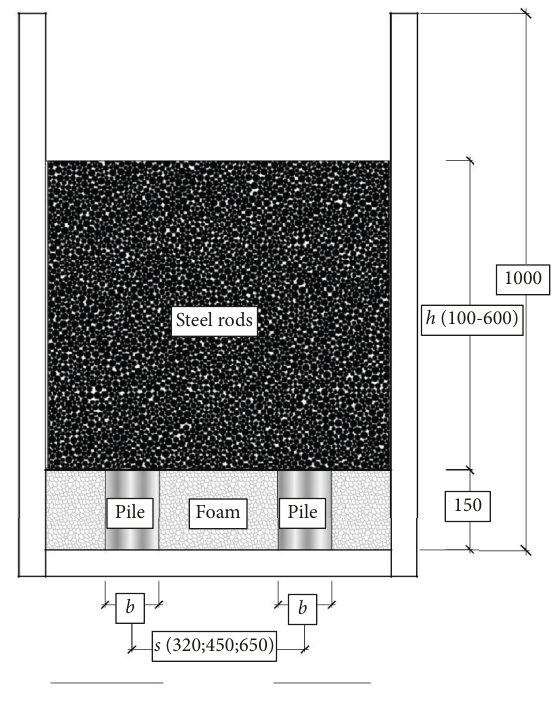
Figure 1: Configuration diagram of the reference case (dimensions in